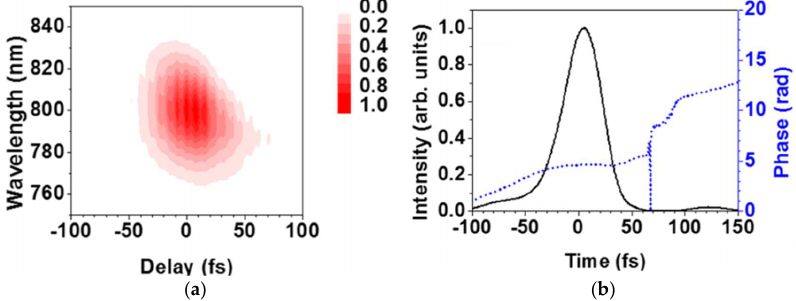
Figure 5. ( a ) SD FROG trace and ( b ) retrieved temporal profile of the reference pulse.